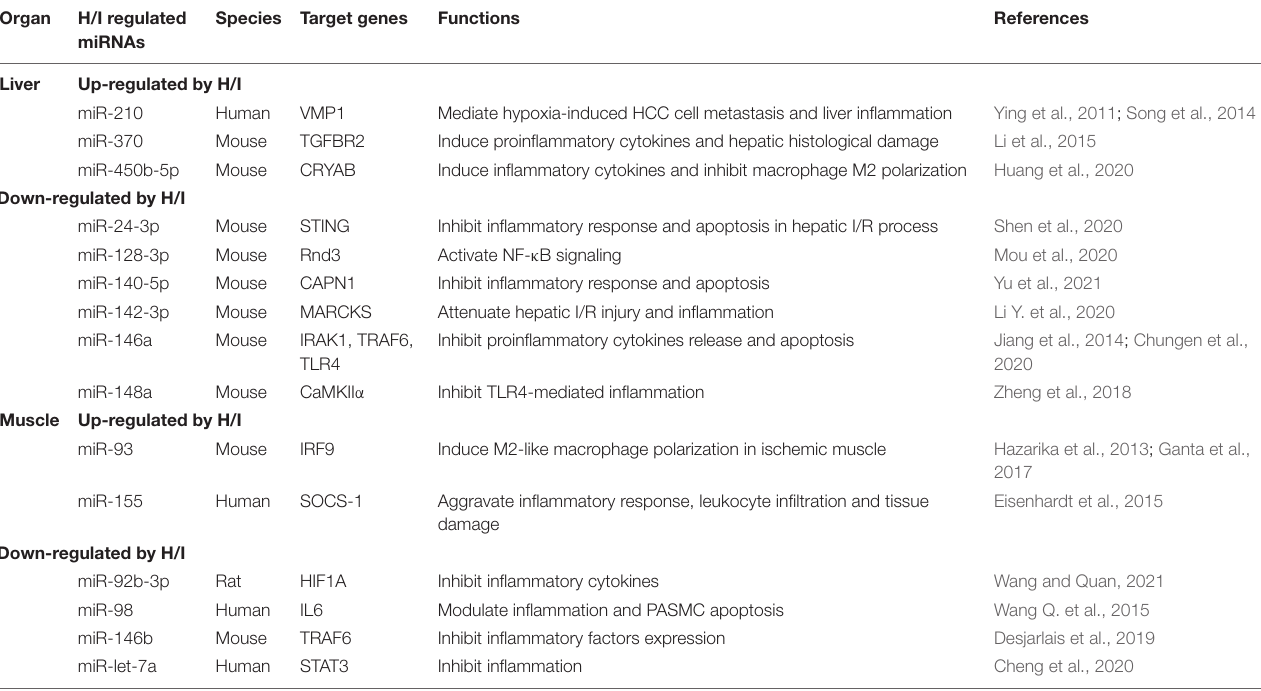
TABLE 4 | H/I-induced changes in miRNAs in H/I-insensitive organs with defined target genes. Organ H/I regulated miRNAs